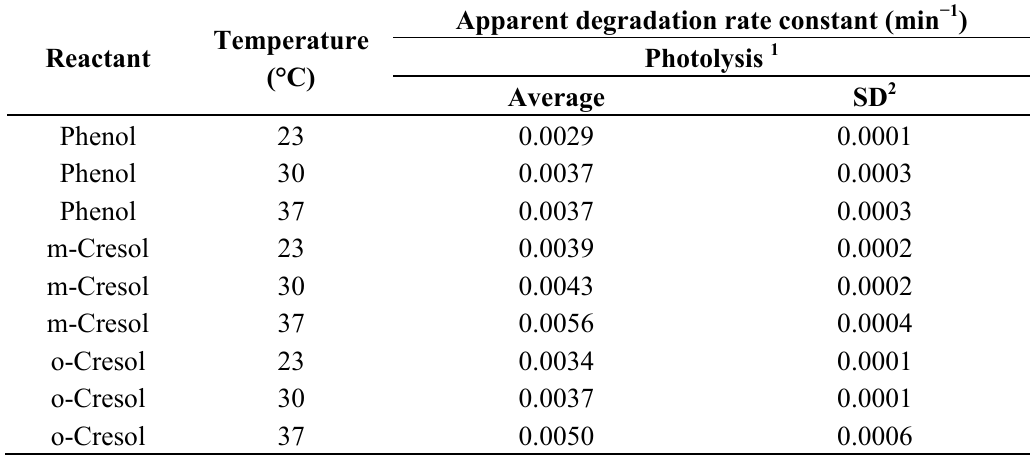
Table 4. Photolytic apparent degradation rate constants for phenol, m-cresol and o-cresol. Apparent degradation rate constant (min − 1 ) Temperature Reactant Photolysis 1 (°C) Average SD 2 Phenol 23 0.0029 0.0001 Phenol